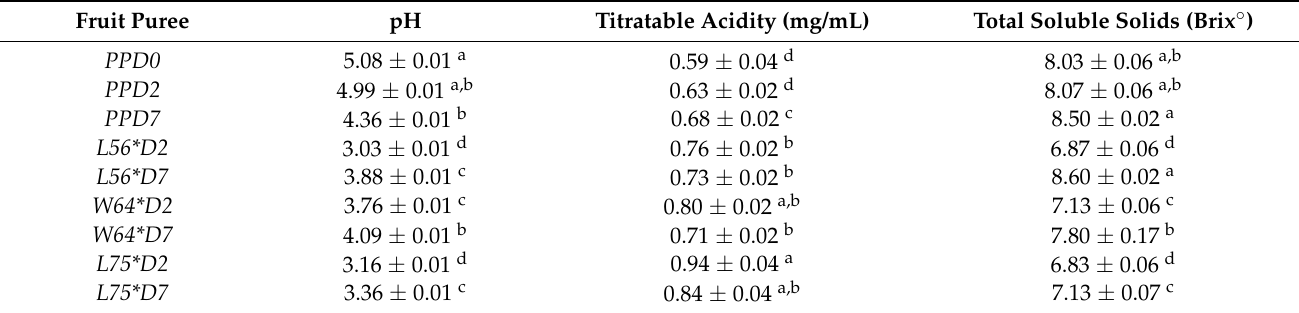
Table 1. Changes in pH and total soluble solids ( ◦ Brix) of non-fermented and fermented papaya puree. Fruit